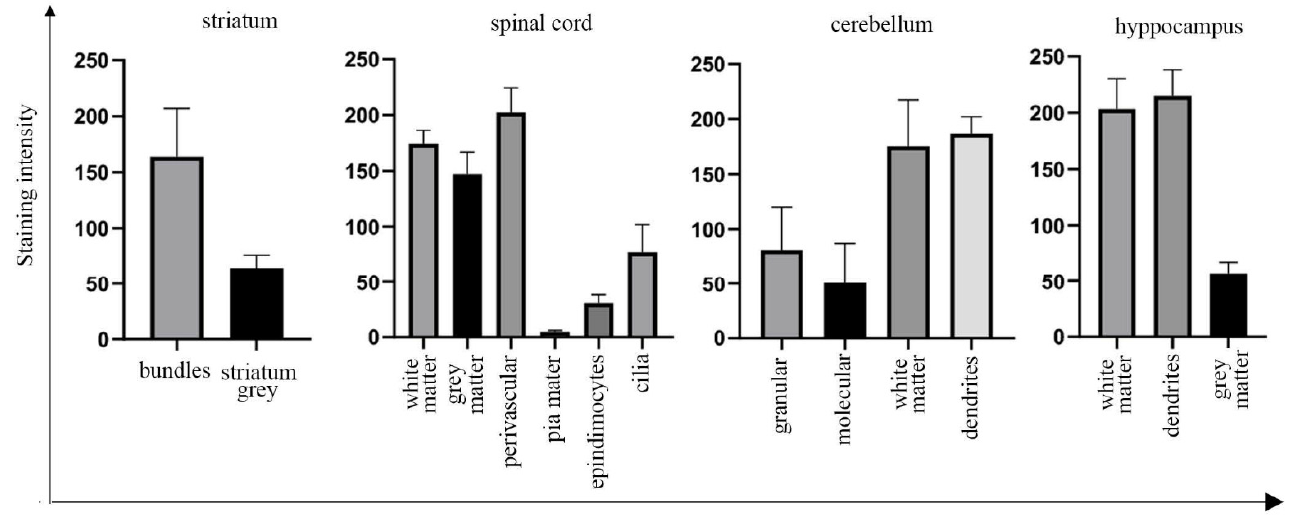
Figure 6. Quantification of UNC-45A expression levels in the mouse central nervous system (CNS) following IHC staining. Quantification of UNC-45A staining intensity in the indicated histological areas of the CNS following IHC staining. Quantification is expressed as mean pixel intensity.